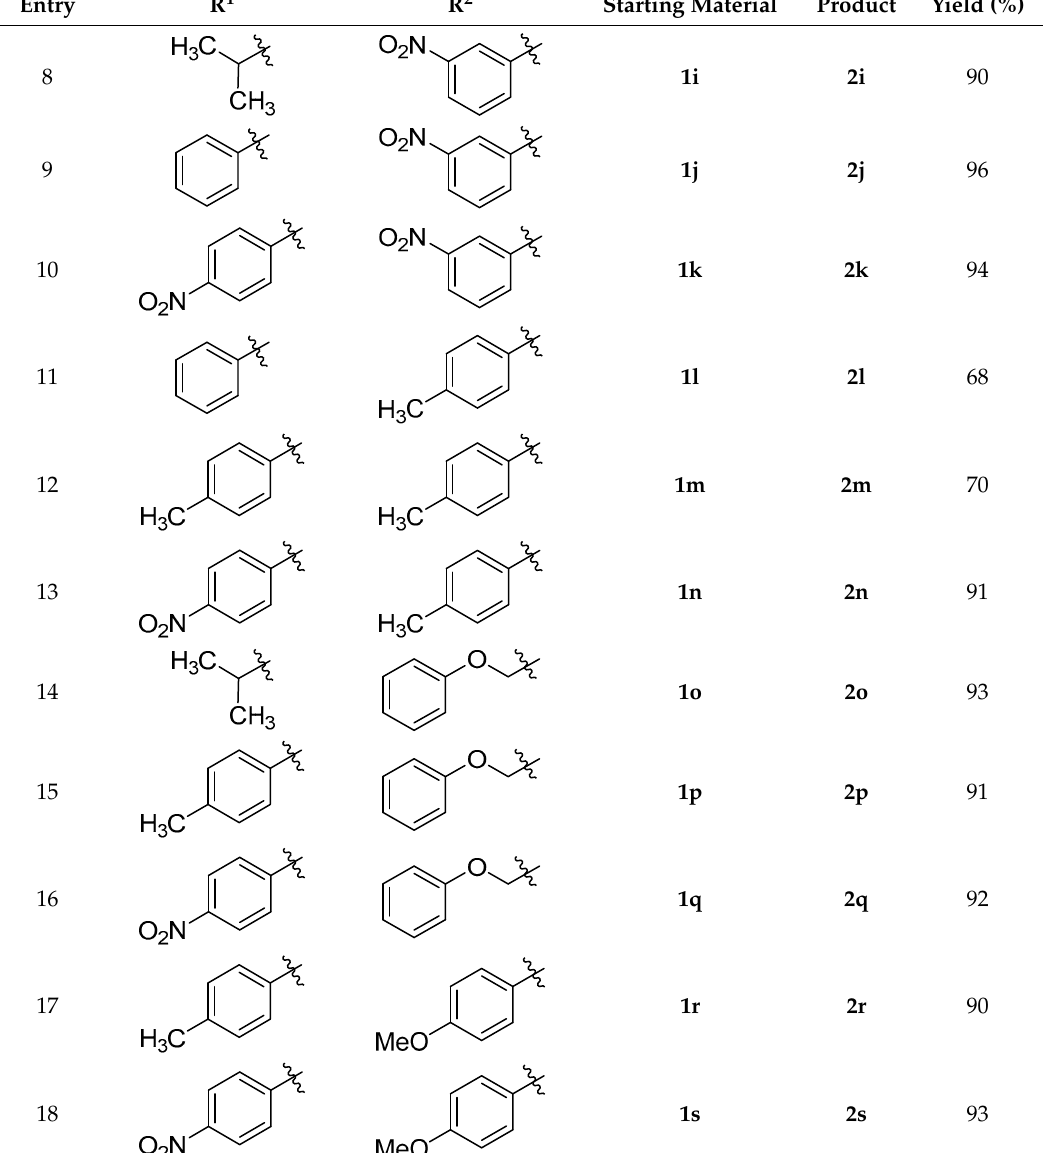
Table 2. Reaction scope of cyclization of the thiosemicarbazide.